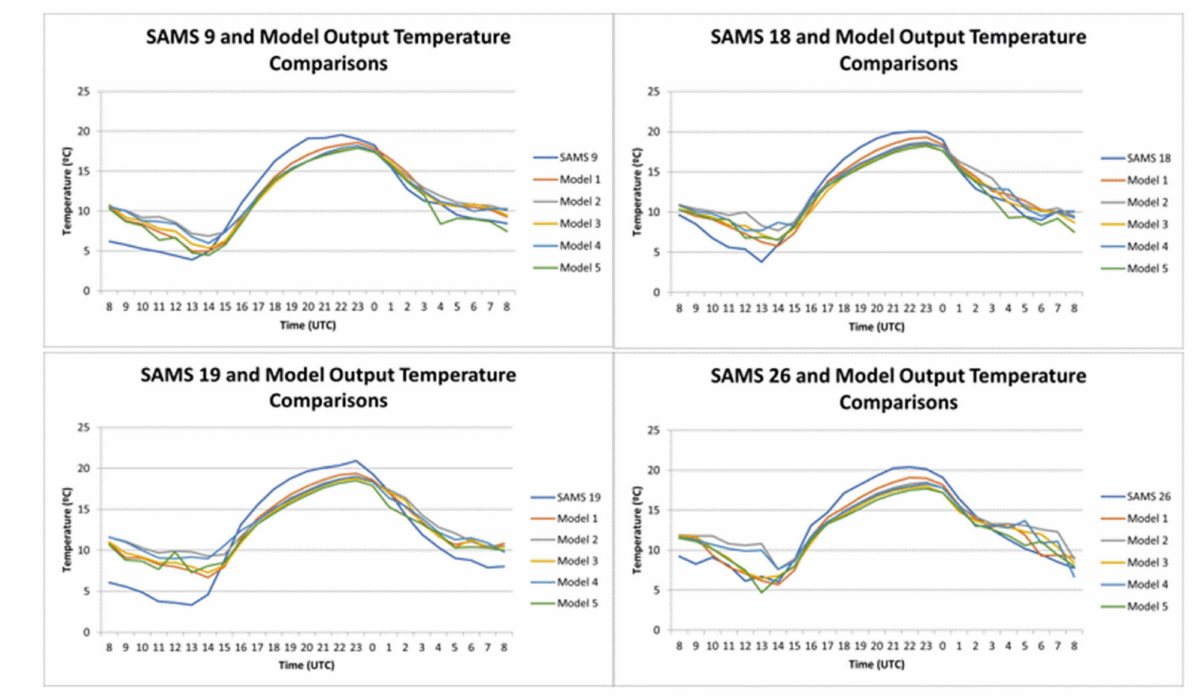
Figure 6. Observed 2 m AGL surface temperature ( ◦ C) compared with model simulated 2 m AGL surface temperature ( ◦ C) for the different experiments MS1 through MS5 across IOP6 at several different SAMS playa sites as shown in Figure 1.